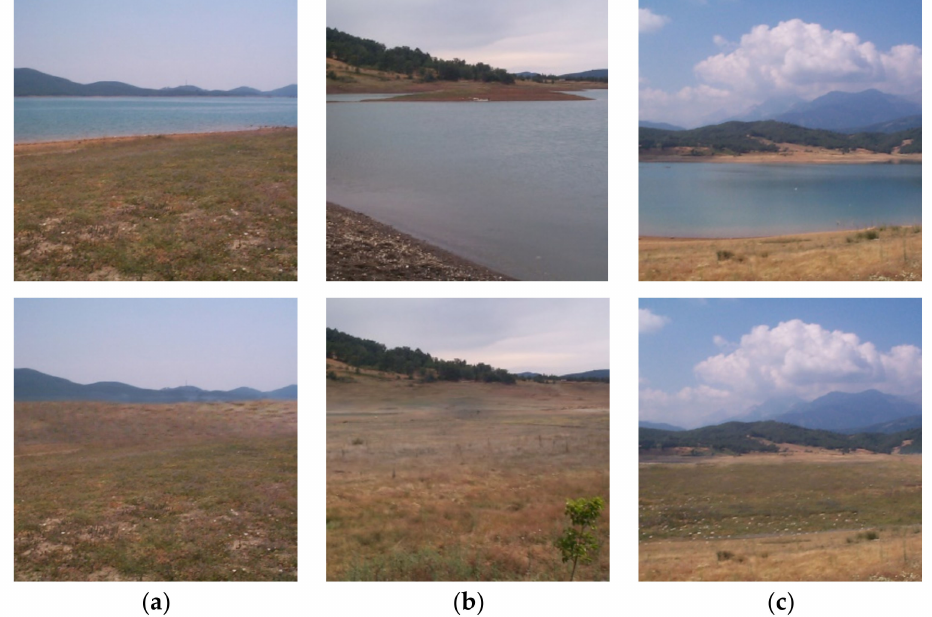
Figure 9. Plastiras reservoir north part; Viewpoints of Figure 6 ( a ) N.d; ( b ) N.e; ( c ) N.f; First row, original view; Second row, transformed images without